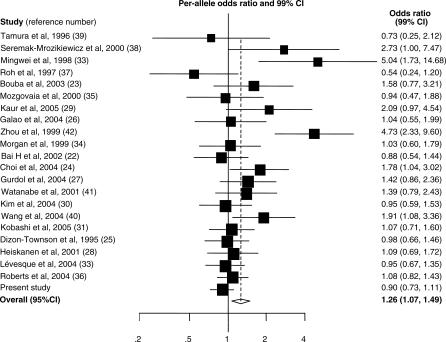
Meta-Analysis of Studies of ACE-I/D Polymorphism and Risk of Preeclampsia